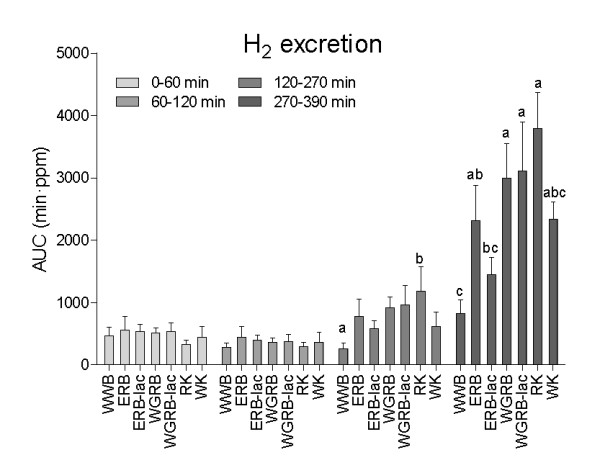
H2 excretion after the breakfast products. Values are means ± SEM, n = 10 (n = 9 for WGRB). Products not sharing the same letters were significantly different. Products not displaying letters were not different from any other test product, p < 0.05 (ANCOVA, followed by Tukey's test).